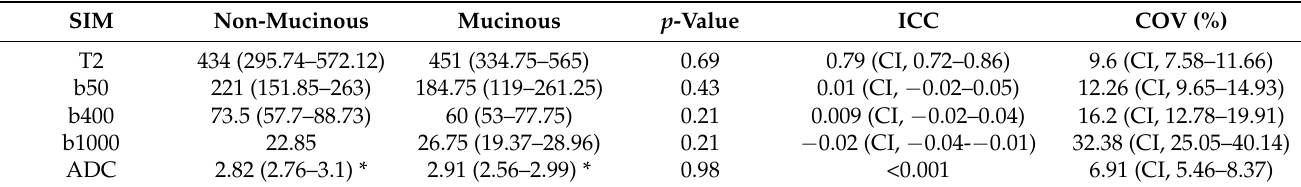
Table 3. Univariate analysis results and intraclass and coefficient of variations for the signal intensity